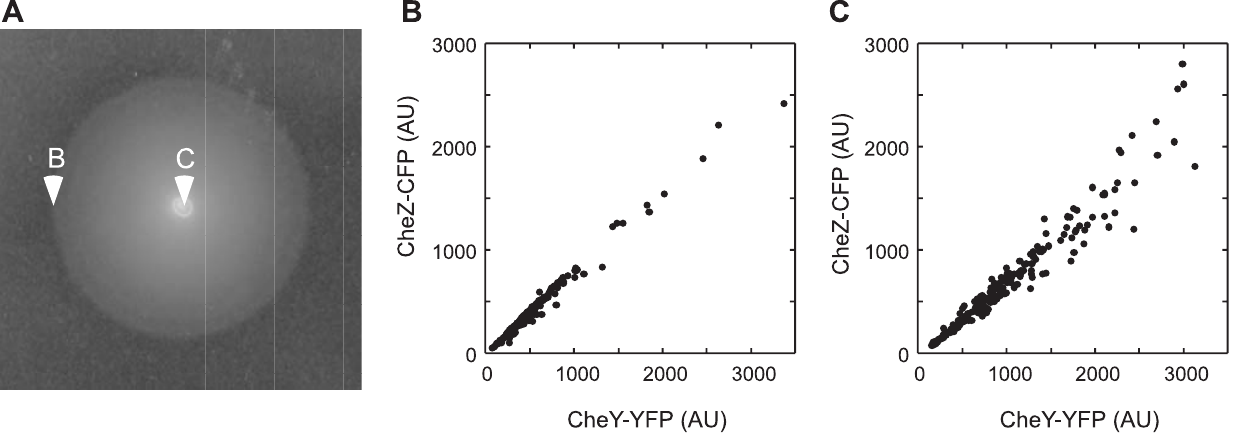
Figure 3. Chemotactic selection for posttranscriptional coupling. (A) Chemotaxis-driven spreading of VS104 [ D (cheYcheZ) ] cells expressing CheY-YFP and CheZ-CFP from a bicistronic construct pVS88 on soft agar (swarm) plates. (B and C) Scatter plots of single-cell levels of CheY-YFP and CheZ-CFP in cells taken from the edge (B) and from the middle (C) of the spreading colony. Relative concentrations of fluorescent proteins in individual cells were determined using fluorescence microscopy as described in Materials and Methods. Protein expression was induced with 17 m M IPTG; data for 10 m M IPTG induction are shown as supporting Figure S3. AU, arbitrary units.